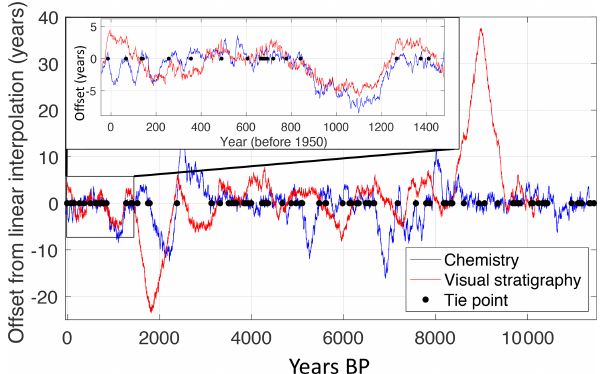
Figure 9. Comparison between visible layer (red) and chemistry- based (blue) Holocene annual timescales. Both curves are shown as residual values with respect to a linear interpolation between tie points (black circles). When the shape of the red and blue curves is similar between tie points, we infer relatively high accuracy in both methods. The region showing the closest agreement between methods is shown in the inset with both curves remaining within 2 years of each other despite a long section with no tie points (841 to